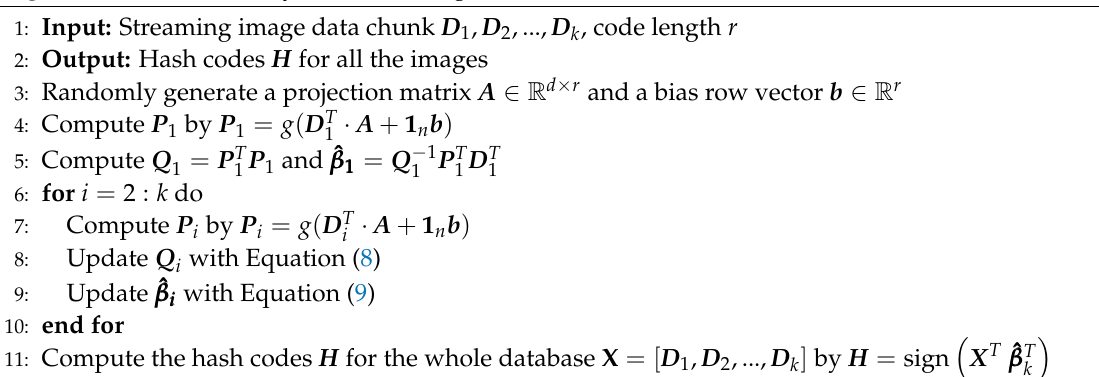
Algorithm 1 Online Binary Code Learning with